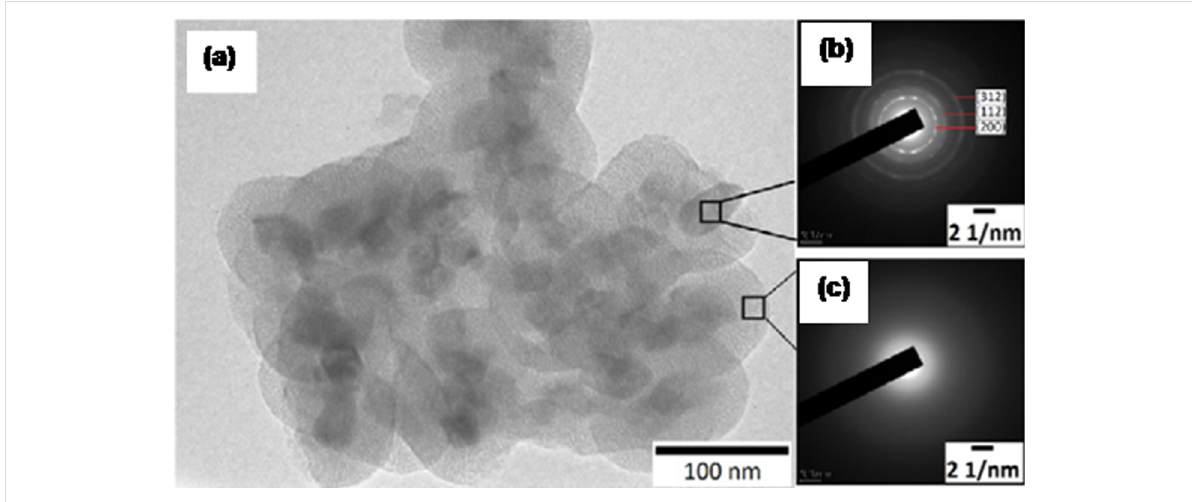
Figure 1: (a) YVO 4 :Eu 3+ NPs encapsulated with mesoporous silica NPs. The insets show SAED patterns of (b) YVO 4 :Eu 3+ and (c) mesoporous silica. Reproduced with permission from [16]. Copyright 2013 IOP